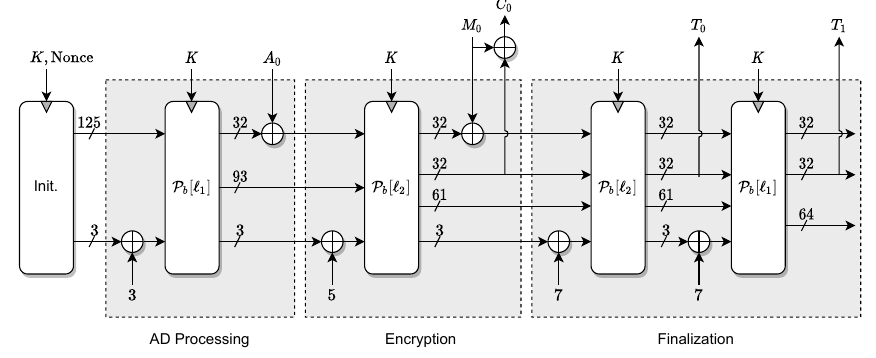
Figure 1: Structure of TinyJAMBU. Table 3: TinyJAMBU and its security goal with a unique nonce [WH19, WH21].